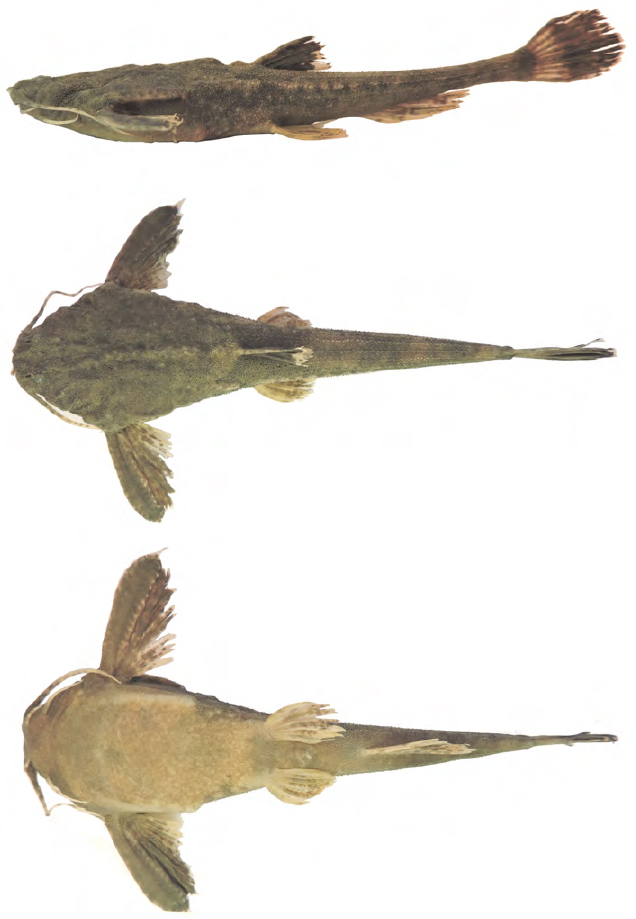
Figure 2. Bunocephalus doriae, CI-FML 7095, 66.1 mm SL, from Bermejo River basin.